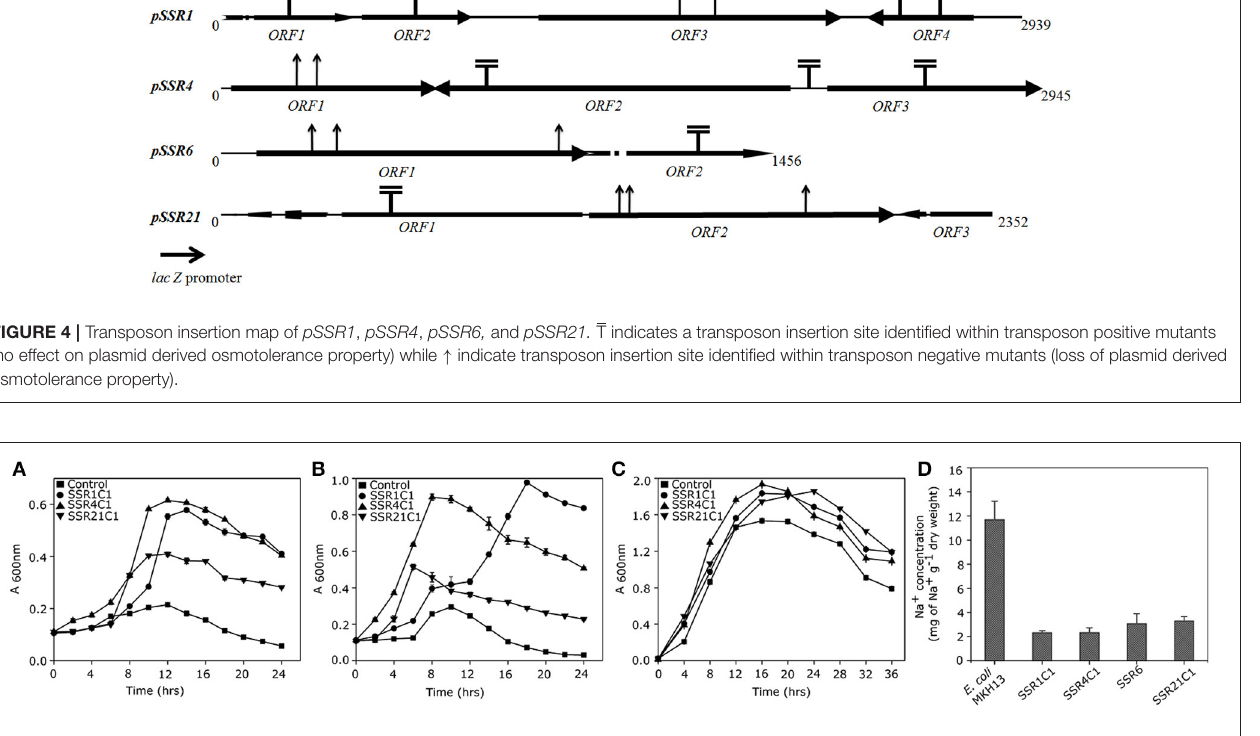
FIGURE 5 | Physiological Characterization of BCAA_ABCTP , GSDH, STK_Pknb, and duf3445 for osmotolerance. Growth curve analysis of osmotolerant phenotype SSR1C1 (•), SSR4C1 ( N ), SSR21C1 ( H ), and E. coli (MKH13) host strain carrying empty plasmid vector ( (cid:4) ) in (A) LB broth supplemented with 3% NaCl (w/v), (B) LB broth supplemented with 3.7 % KCl (w/v), and (C) LB only. Intracellular Na + estimation in E. coli (MKH13) strain harboring pSSR1C1 , pSSR4C1 , pSSR6, and pSSR21C1 and E. coli (MKH13) host strain carrying empty plasmid vector (D)